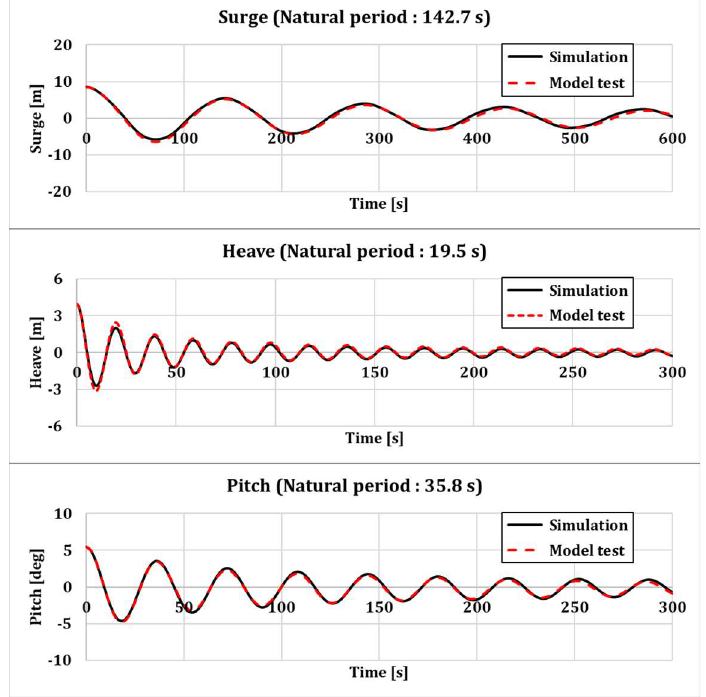
Figure 12. Free decay results of model test and simulation.